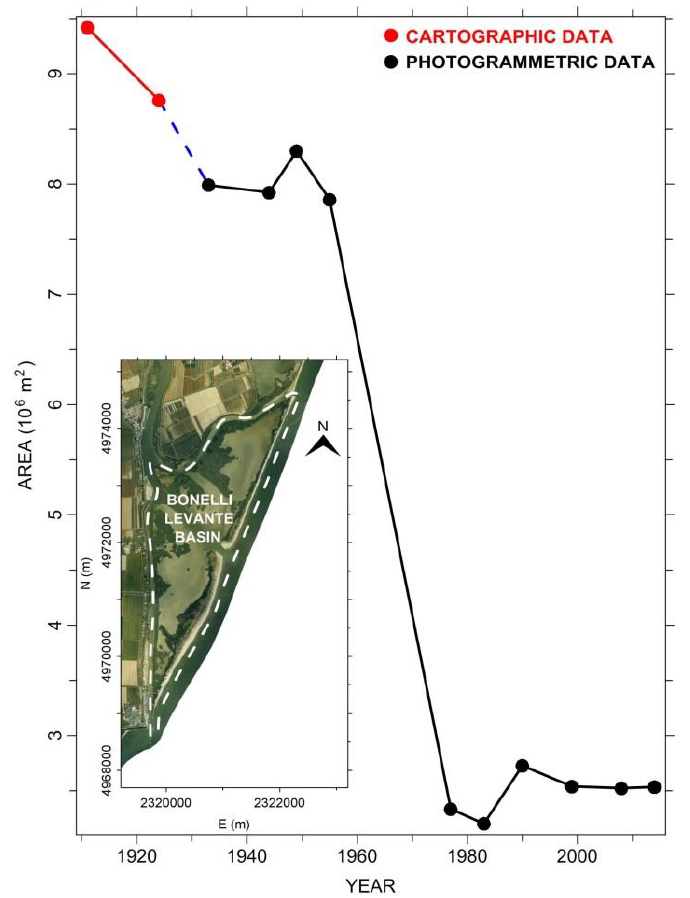
Figure 11. Multi-temporal emerged surfaces relating to sub-area 3 (Bacino Bonelli Levante) from 1911 to 2014 (two cartographic and 12 photogrammetric data): the storm surge event of 10 November 1957 [30], was intercepted in the comparison 1955–1977.